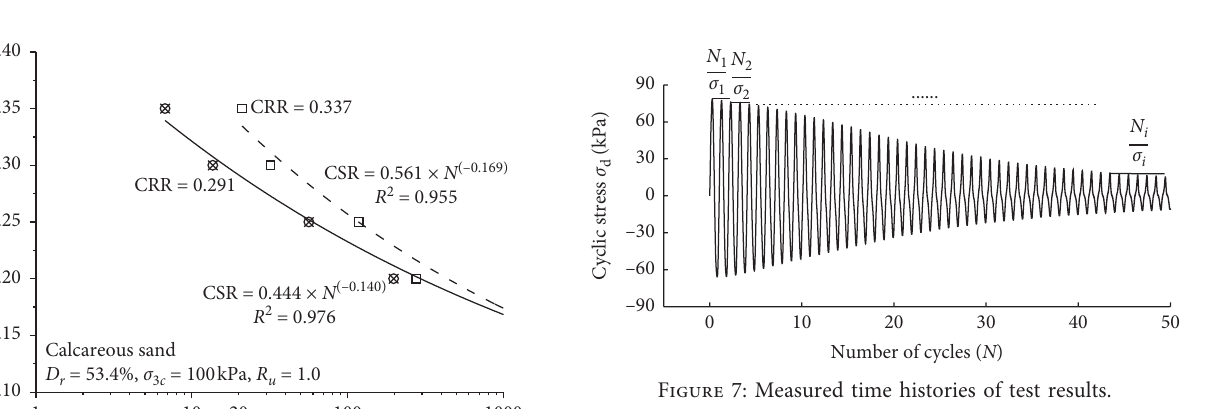
Figure 7: Measured time histories of test